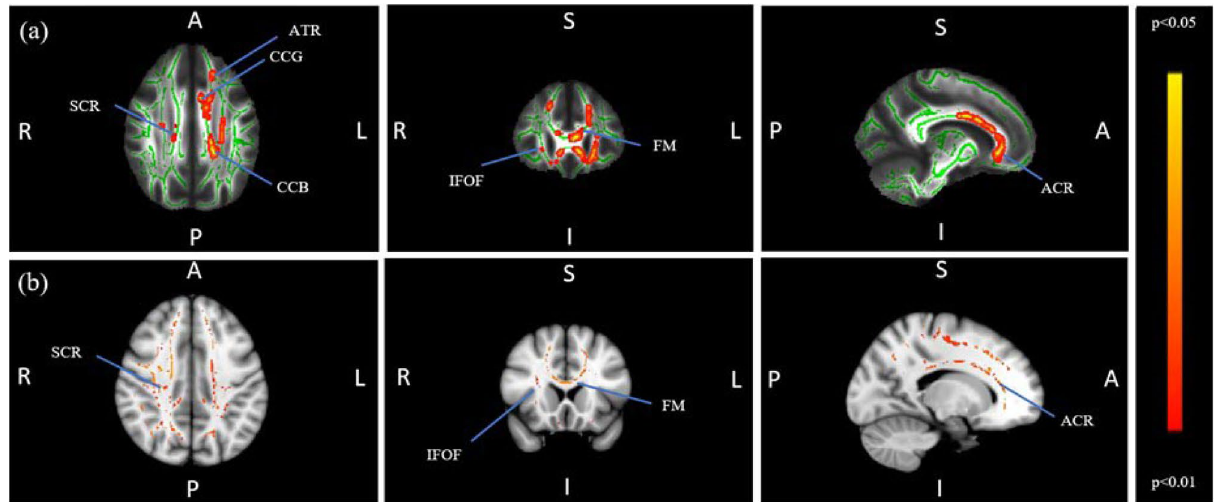
Figure 1. Row ( a ) Regions of significant difference in group level FA analysis (CON > TIN). Green represents the mean FA of all participants. The red-yellow scale represents regions of significant difference, with red representing regions of greatest difference. The regions showing significant differences between the groups included the right inferior fronto-occipital fasciculus (IFOF), right superior corona radiata (SCR), forceps minor (FM), genu (CCG) and body (CCB) of the corpus callosum, left anterior corona radiata (ACR), left anterior thalamic radiation (ATR), bilateral superior longitudinal fasciculus and left inferior longitudinal fasciculus (not visible in this view). Row ( b ) Regions of significant difference in group level MD analysis (CON < TIN). The red- yellow scale represents regions of significant difference, with red representing regions of greatest